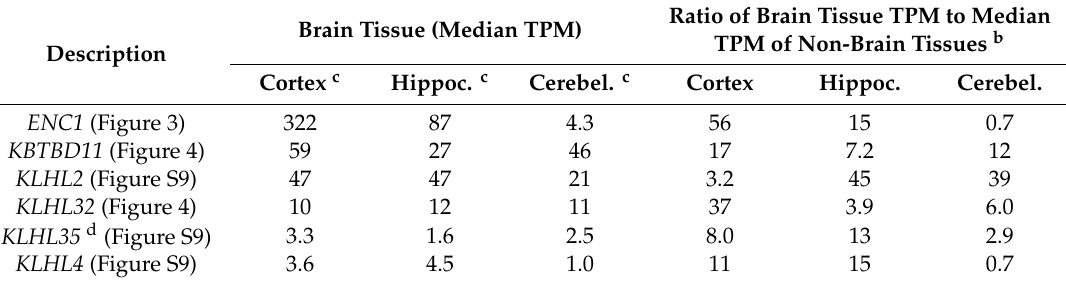
Table 2. KLHL family genes that are preferentially expressed in brain a